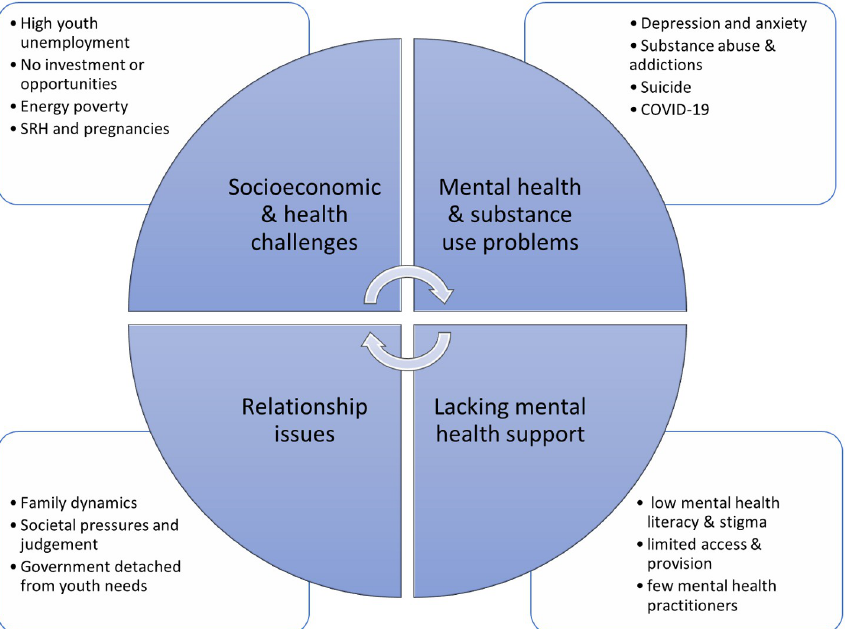
Fig 2. Thematic map of main findings. Bullet point around the cycle represent subthemes linked to each main themes.